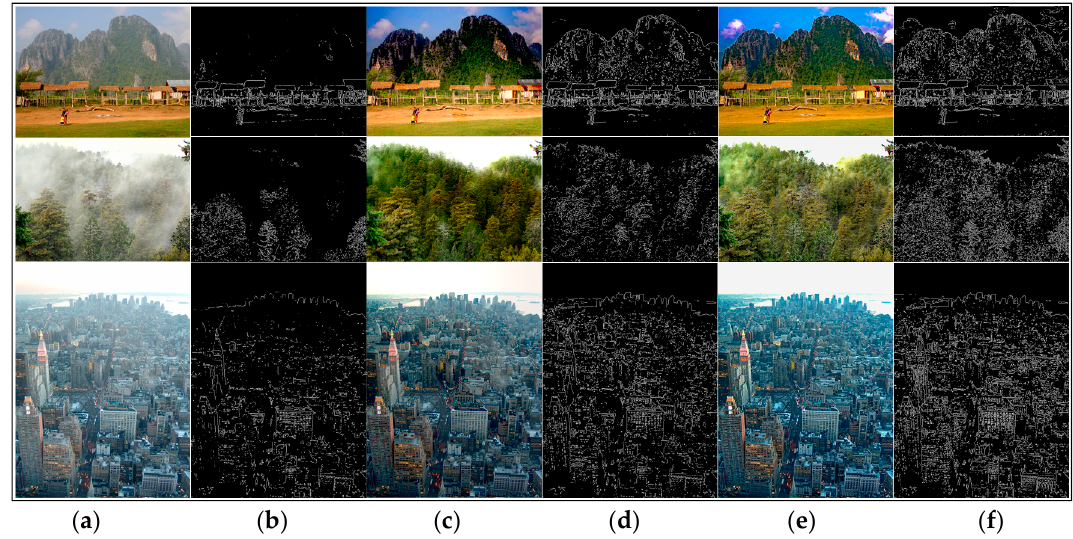
Figure 8. Comparison of our method to the method by Fattal [12] using real-world images. ( a , b ) are input hazy images and their corresponding visible edges, respectively; ( c – f ) are the dehazing results with corresponding visible edges generated by the method of Fattal [12] and ours, respectively.